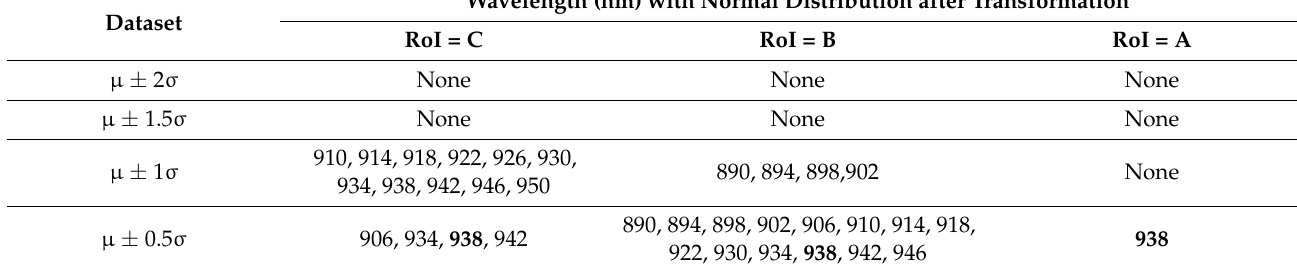
Table 1. Wavelengths extracted from infected images that were successfully transformed to a normal distribution after data reduction.